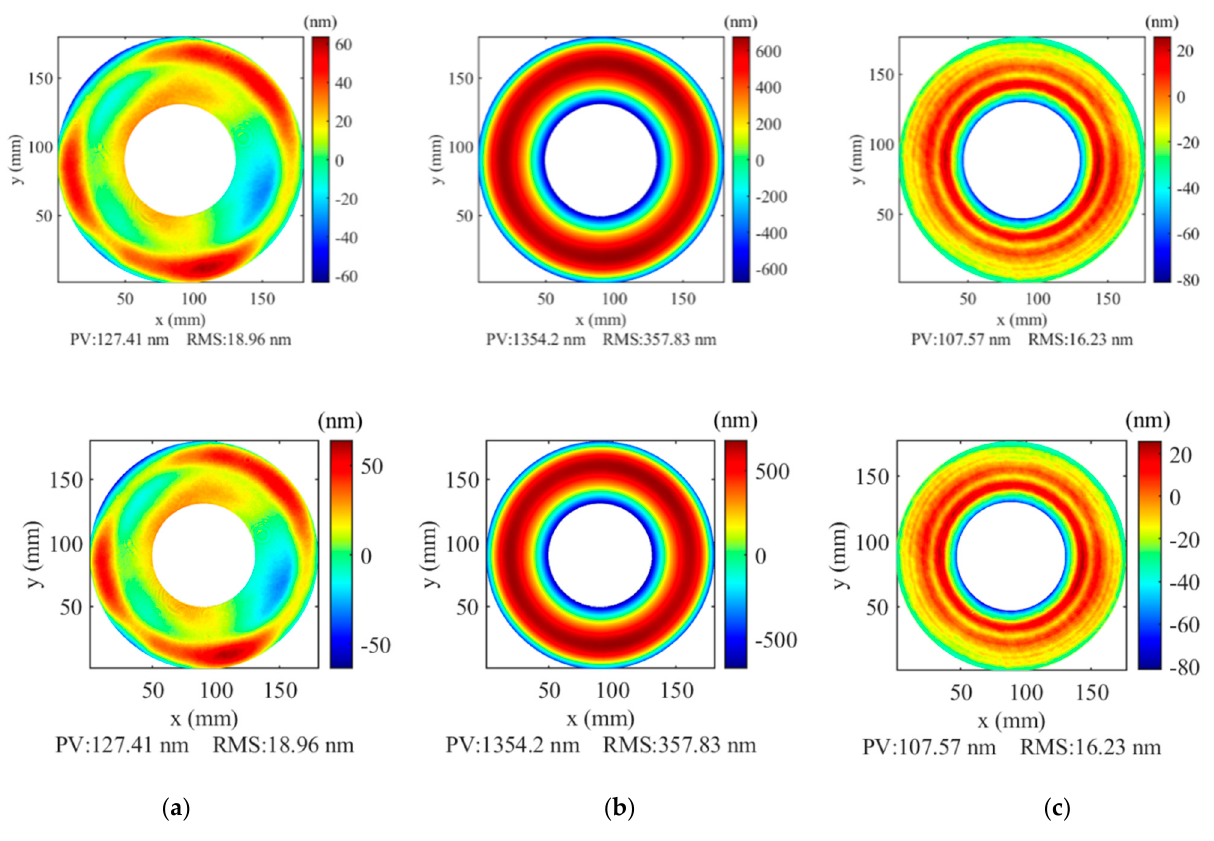
Figure 18. ( a ) The surface topography before coating; ( b ) the surface topography after coating; ( c ) the fabrication error.